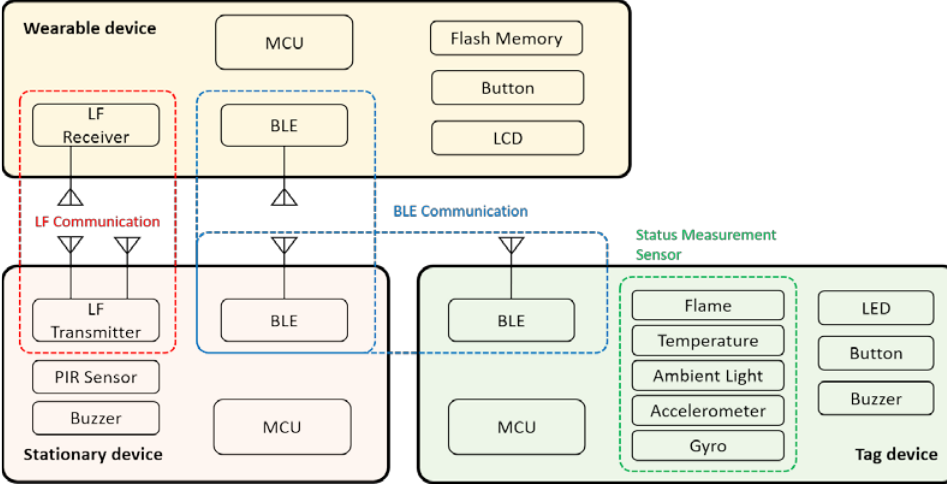
Figure 7. Hardware and communication block diagrams (wearable, tag, and stationary devices).